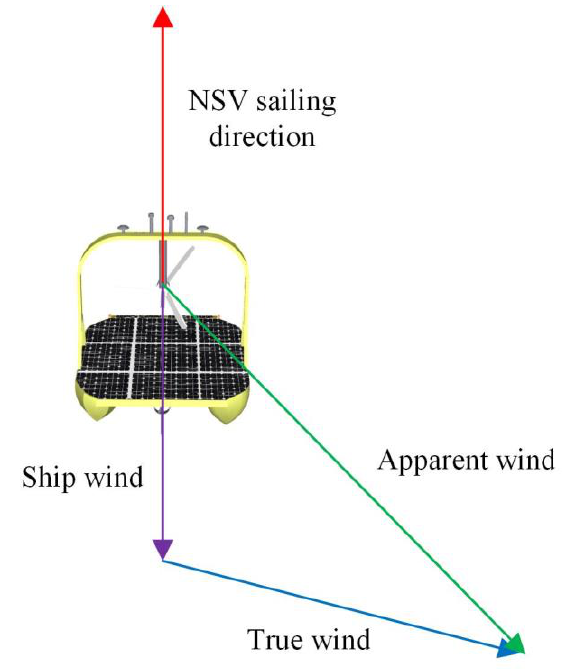
Figure 5. Schematic diagram of apparent wind.